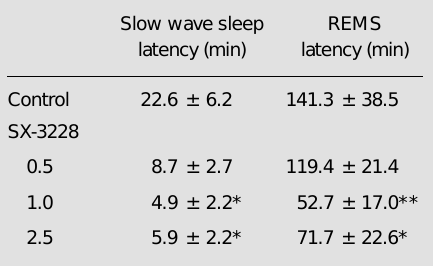
Table 2 - Effect of SX-3228 on sleep latencies during the dark phase of the light-dark cycle. Values are reported as means ± SEM. Six animals were in each experimental group. The doses are reported as mg/kg. *P<0.05; **P<0.01 compared to control (Newman-Keuls test). REMS, Rapid-eye- movement